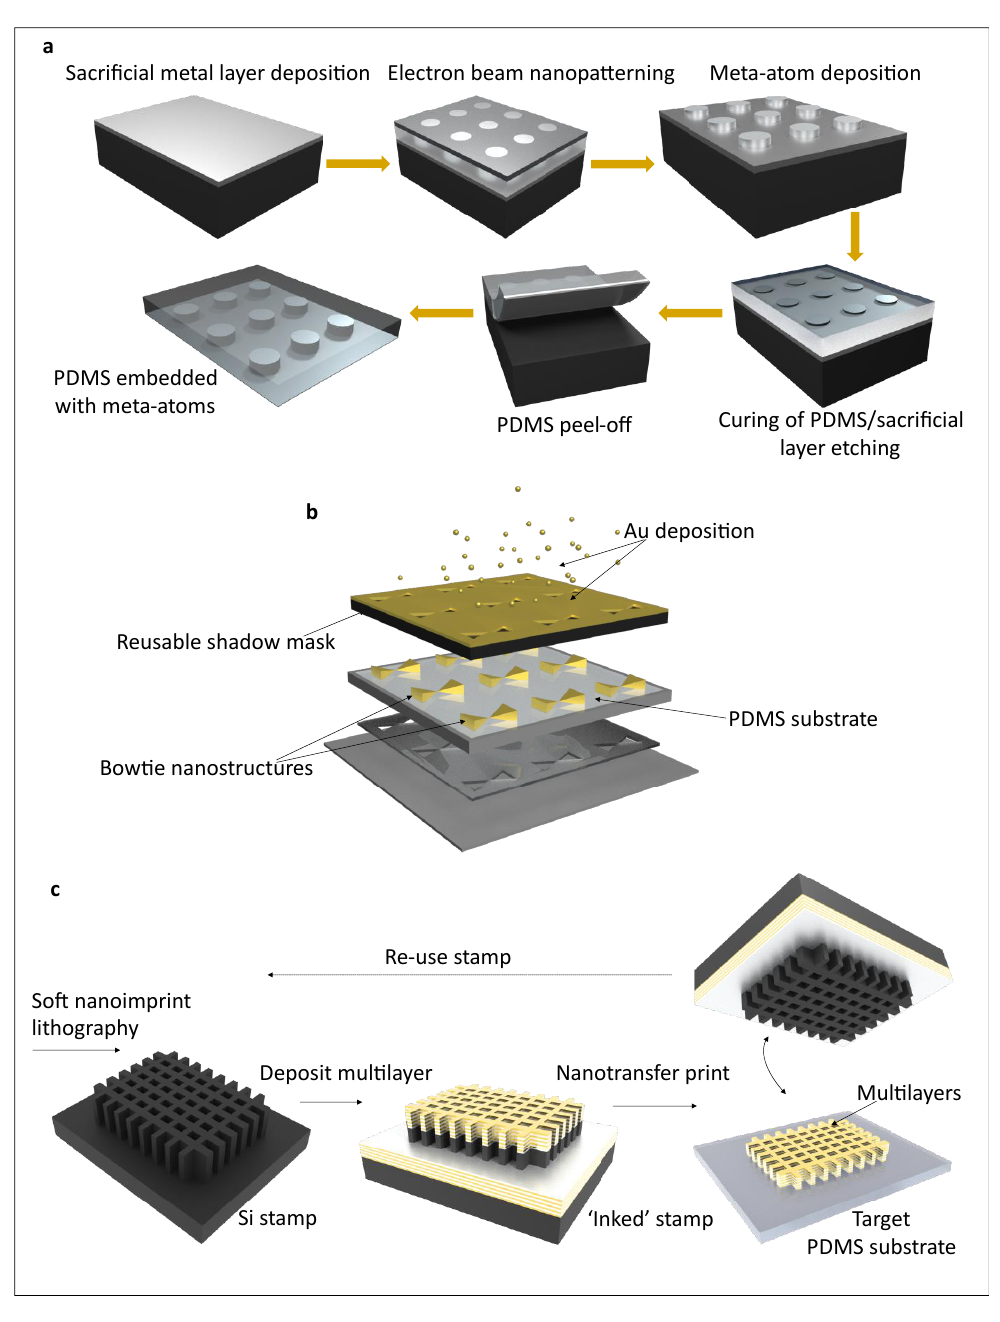
Figure 3. Schematics of the fabrication process of mechanically tunable metasurfaces based on de- formable substrates. ( a ) Conventional lithography – soft lithography. A sacrificial metal layer is de- posited on a silicon substrate by electron beam lithography. After coating the layer with an SU8